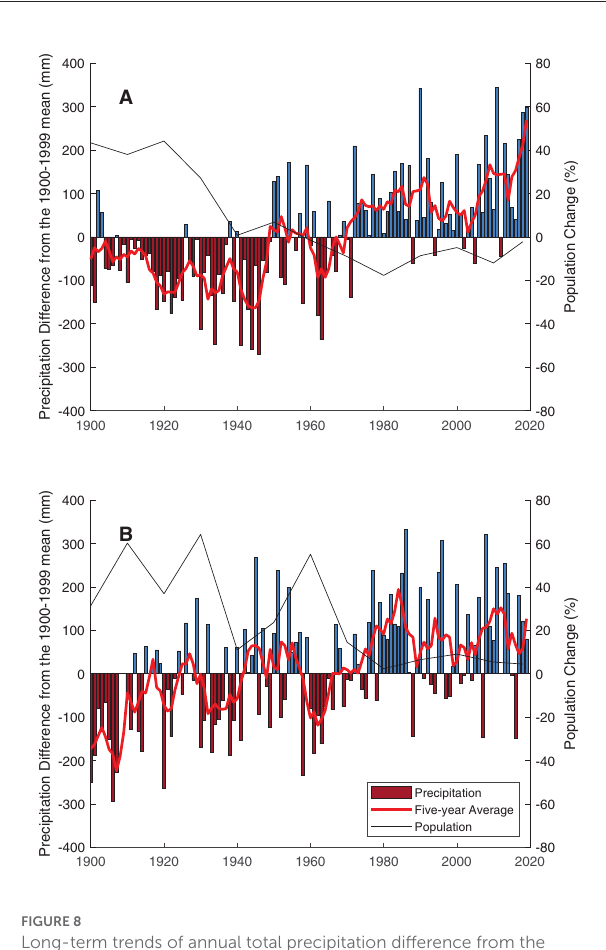
FIGURE8 Long-term trends of annual total precipitation difference from the 120-year (1900–2019) mean for (A) the shrinking cities and (B) the growing